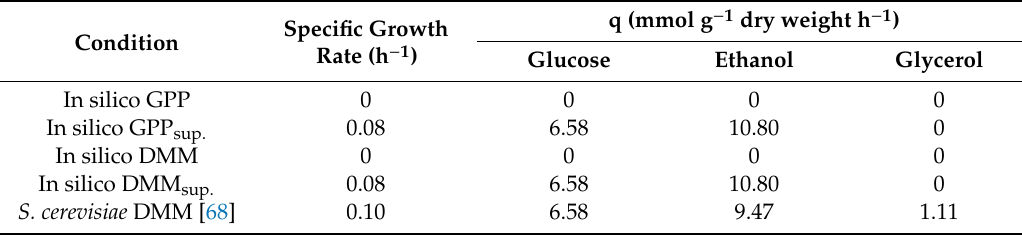
Table 5. Anaerobic growth assessment of iRV781 model in defined media with or without anaerobic supplements. DMM [68] (defined minimal medium); DMM sup. [68] (defined minimal medium supplemented with ergosterol and Tween 80); GPP [67] (glucose-phosphate-proline); GPP sup. [67] (glucose-phosphate-proline supplemented with oleic acid and